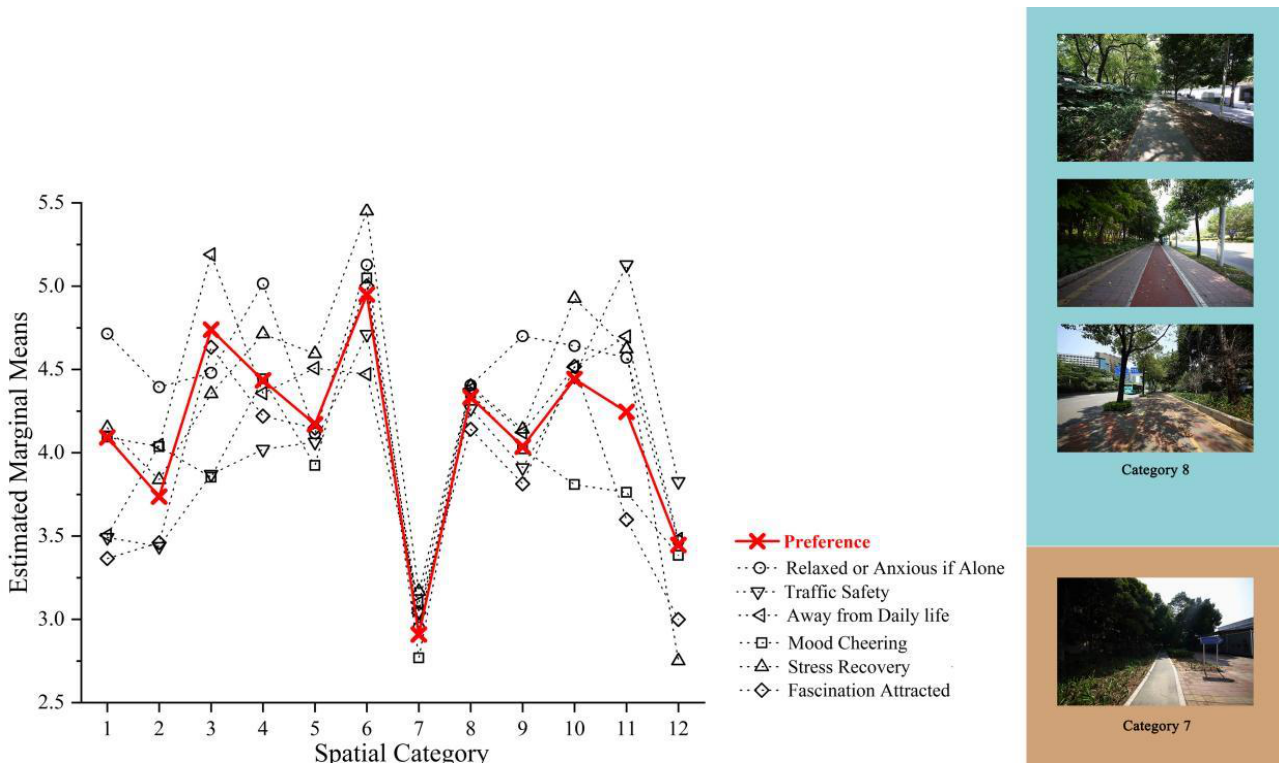
Figure 7. The data offset rate of estimated marginal means of spatial category.